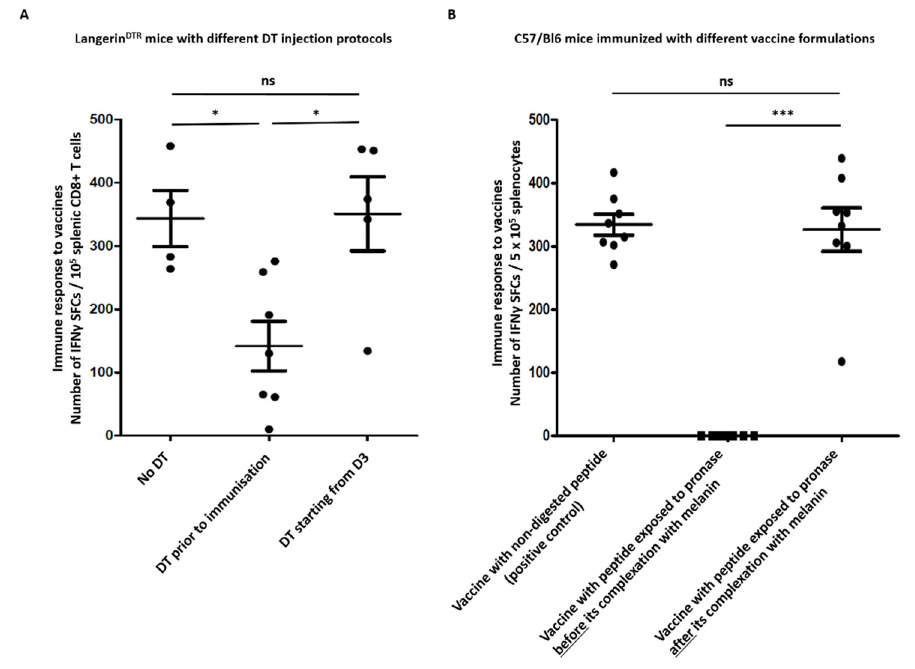
Figure 5. L-DOPA acts as a carrier for peptides, and Langerin + cells carry melanin–peptide aggregates into lymph nodes. ( A ) ELISpot analysis of splenocytes 7 days after immunization with [gp100-Mel + CpG] vaccine in Langerin DTR mice treated with DT (diphtheria toxin) prior to immunization, 3 days after immunization, or not treated with DT (positive control, mice with Langerin + cells not depleted). Data are presented as normalized number of IFN γ spot-forming cells (SFCs) per 10 5 CD8 + T cells based on flow cytometry analysis. ( B ) ELISpot analysis of splenocytes on day 7, after immunizations on day 0 with different vaccine formulations. Each point represents an individual mouse (n = 8 mice/group with pooled data from 2 different experiments). Bars = mean values ± SEM. * p < 0.5, *** p < 0.001, ns = not significant.